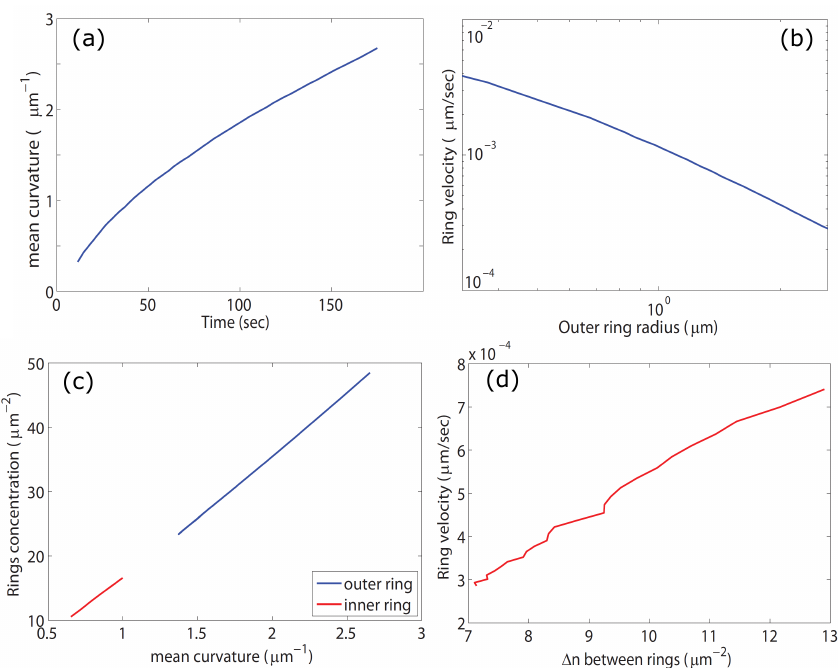
Figure 2. ( a ) the radius of the outer membrane disk (and later ring) as a function of time (all panels correspond to the simulation shown in Figure 1). ( b ) a log plot of the expansion speed of the outer radius vs the radius. We see that the graph is curved at small radii (where the ring is actually a disk) but as the radius grows (and the ring forms) the graph approaches a straight line indicating the power law relation: V ring ∼ 1/ R . ( c ) the peak values of the differential concentration n - n 0 at the inner (red) and outer (blue) rings as a function of the local membrane curvature. We see the the concentrations are linear in the curvature, as given by Equation (3). ( d ) the ring outwards velocity as a function of the difference in concentrations between the inner and outer activators